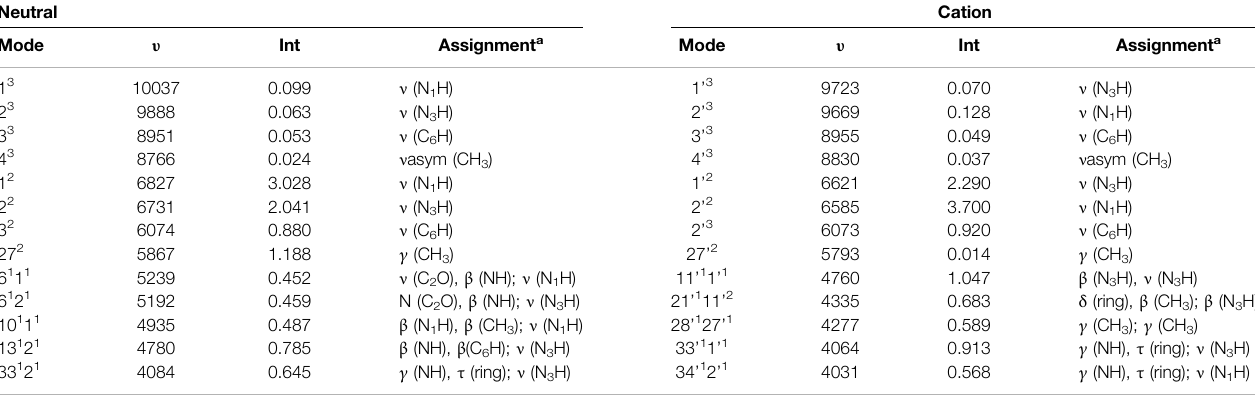
TABLE 4 | NIR spectra computed at the GVPT2//B2PLYP//B3LYP/AVTZ level, wavenumbers ( υ , cm − 1 ), IR intensities (km/mol) and assignment. Neutral Cation Mode